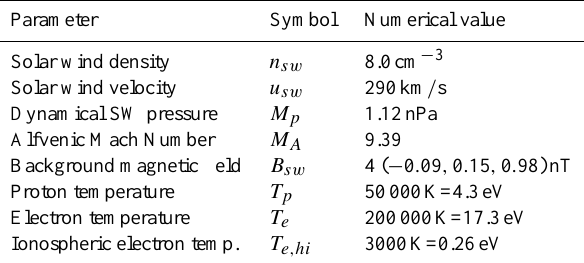
Table 2. Input parameters for the